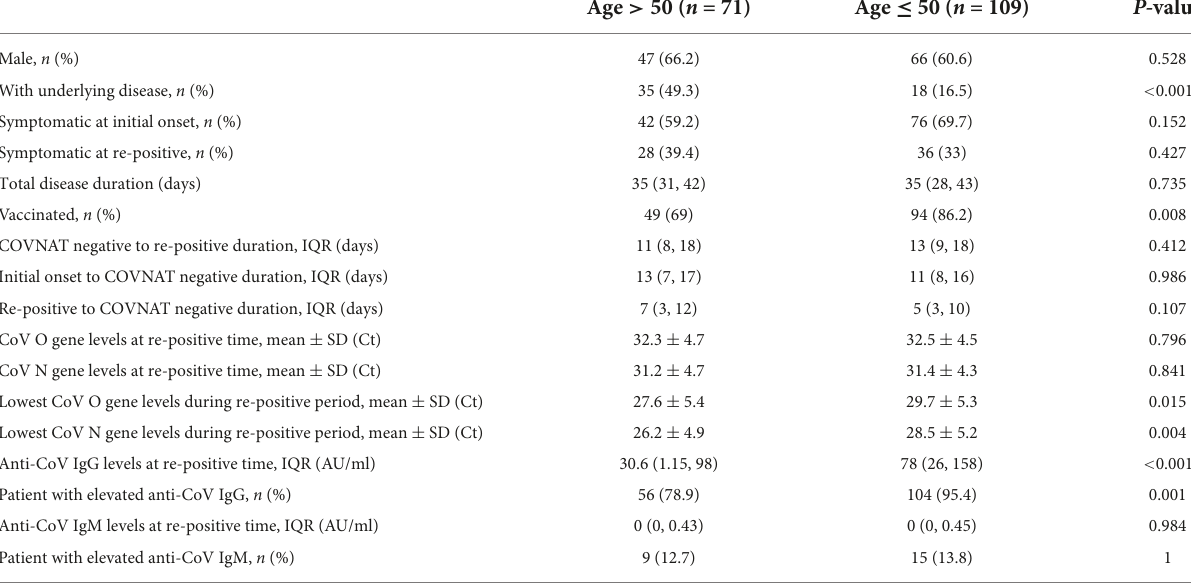
TABLE 3 Comparison of clinical characteristics and laboratory results between patients > 50 and ≤ 50 years old.